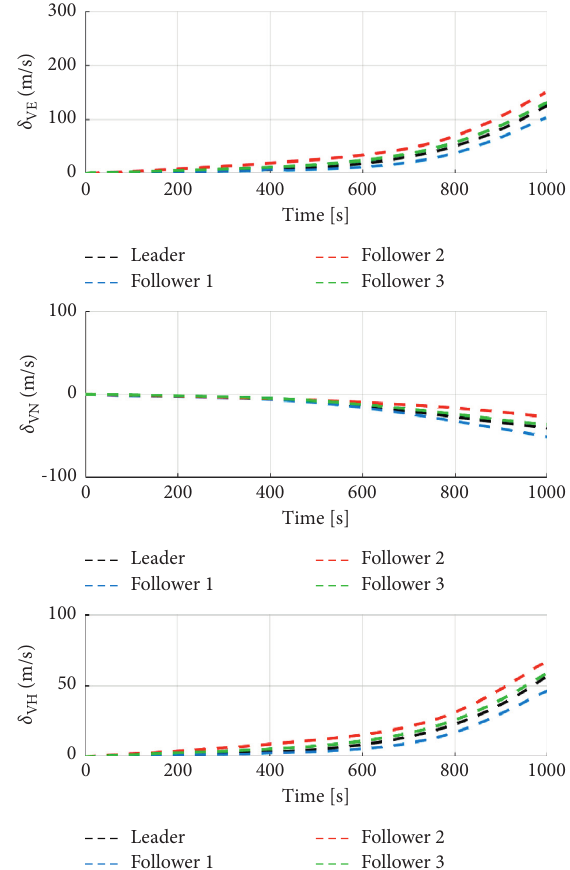
Figure 9: Velocity curves of the strap-down inertial navigation system.